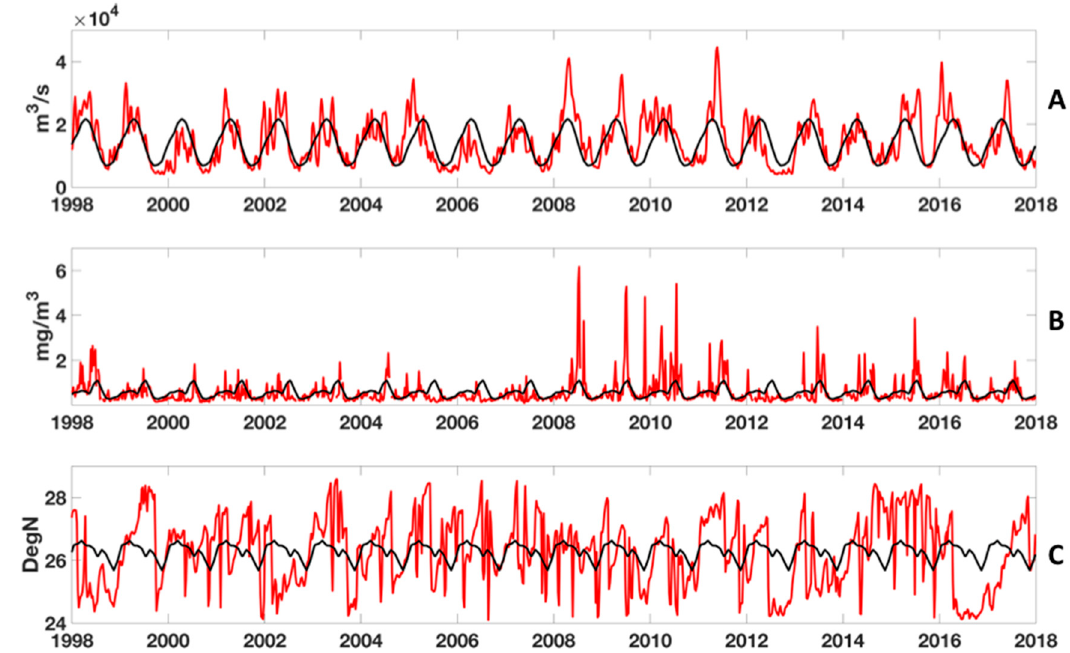
Figure 5. ( A ) Time series of Mississippi River discharge. ( B ) Time series of SeaWiFS and MODIS-Aqua chlorophyll-a concentration extracted from satellite data representing the Mississippi River plume offshore export (polygon in Figure 1). ( C ) Time series of the northernmost extent of the Loop Current. In each plot, the red line represents the time series binned to weekly intervals, while the black line represents the weekly climatology calculated using data from years 2003 to 2017.